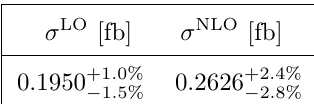
Table 5. Scale uncertainty for the process pp ! e (cid:0) (cid:22) (cid:23) e (cid:22) + (cid:23) (cid:22) (cid:28) + (cid:23) (cid:28) + X at a CM energy of 13 TeV obtained by varying the renormalization and the factorization scale together up- and down by a factor of